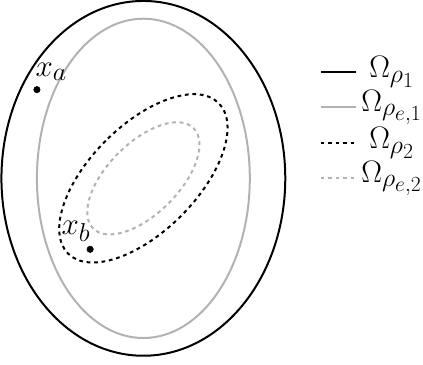
Figure 3. Intersecting stability regions with two different potential initial conditions x ( t k ) = x a and x ( t k ) = x b